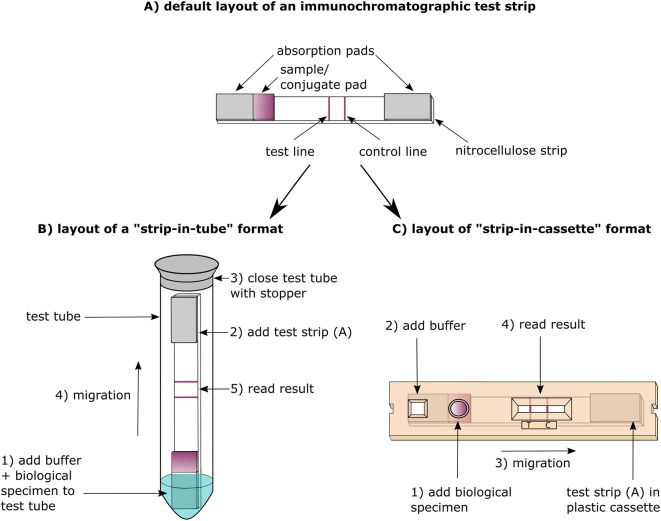
Design and principle of antibody vs. antigen detection lateral-flow immunochromatography assays (LFIA).